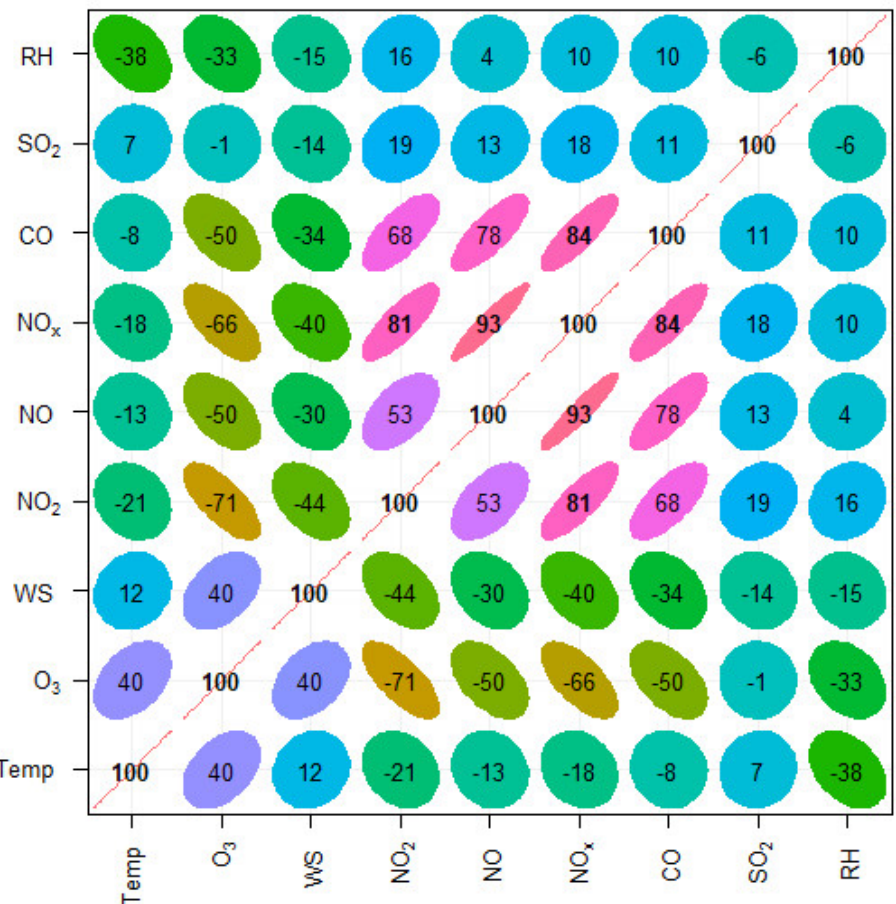
Figure 4. Correlation between various air pollutants and meteorological parameters. Decimal point is not shown to facilitate presentation (e.g., 0.93 is shown as 93).